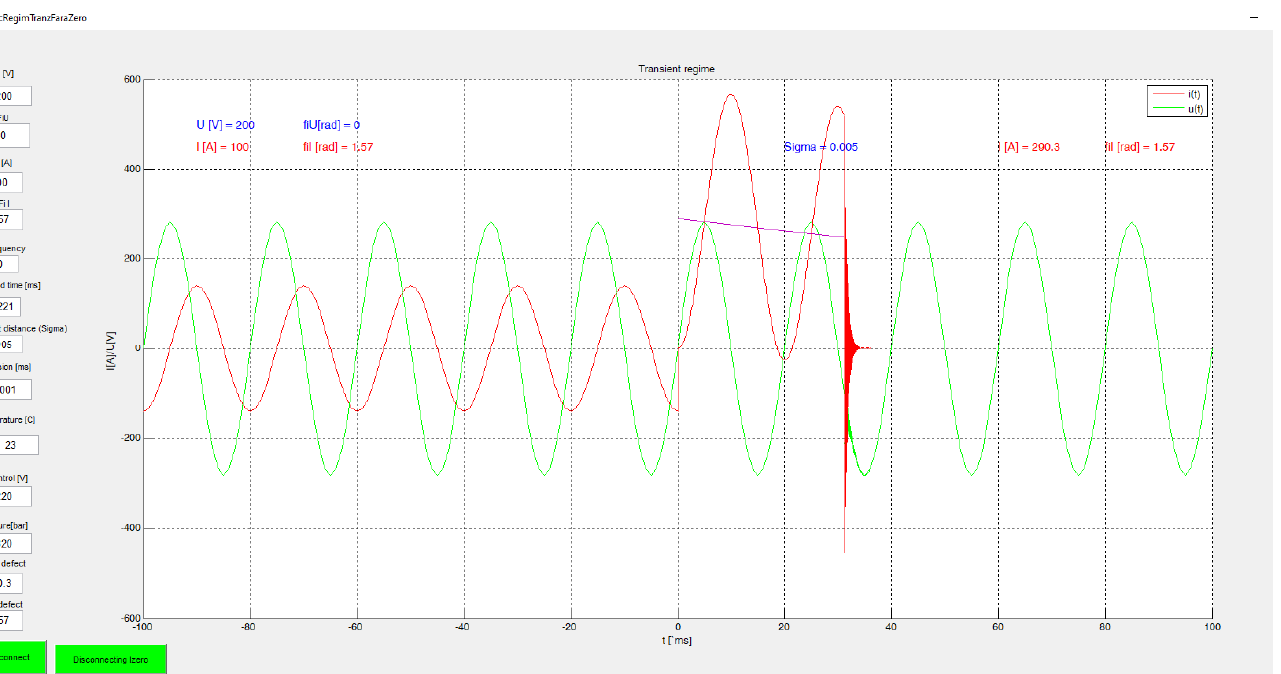
Figure 17. Transient switching diagram for inductive load, ɸ Idef = π /2, Idef = 290.3 A, σ = 0.005, t command = 50.121 ms, t disconnect = 77.375 ms.